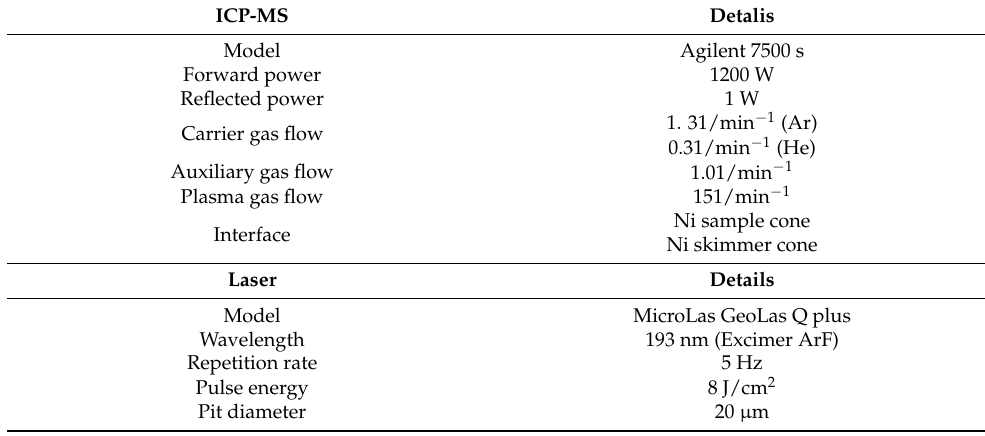
Table 1. Operating conditions for the